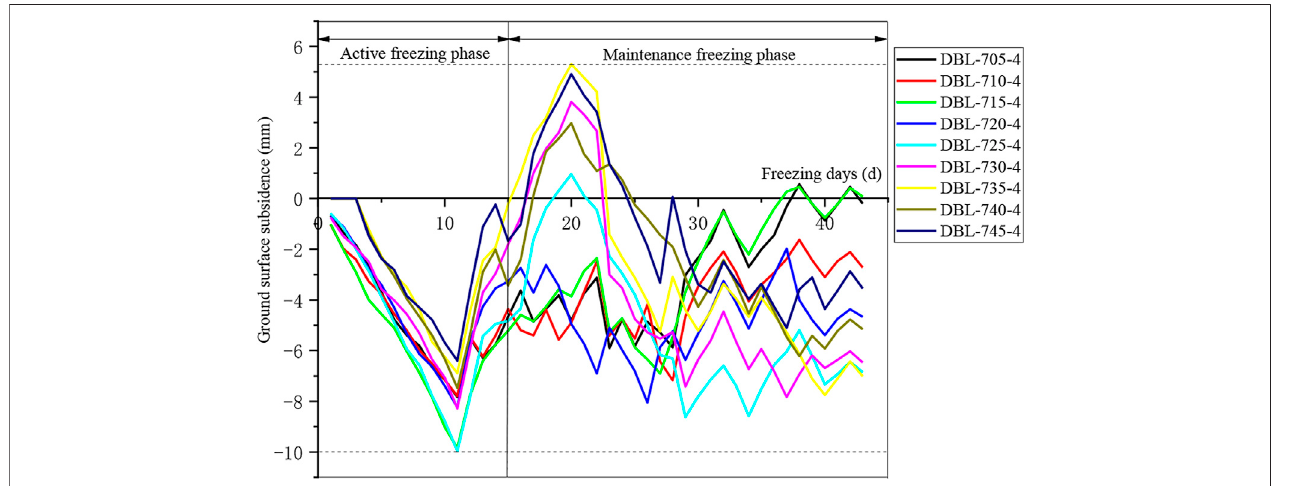
FIGURE 14 | Cumulative value of ground surface freezing and steel sleeve receiving at the western end of Zhuyuan Road.